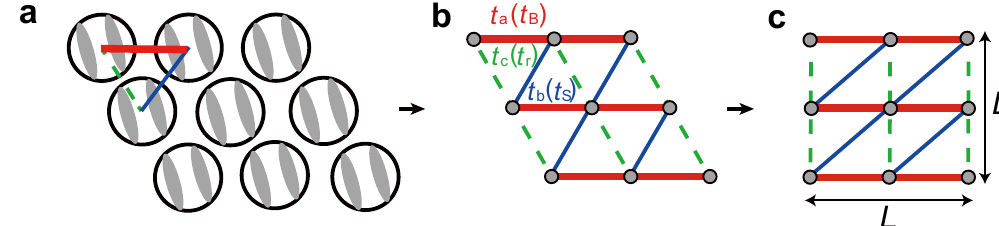
~ b ), and t c (on the green bond ~ c ), respectively, (they